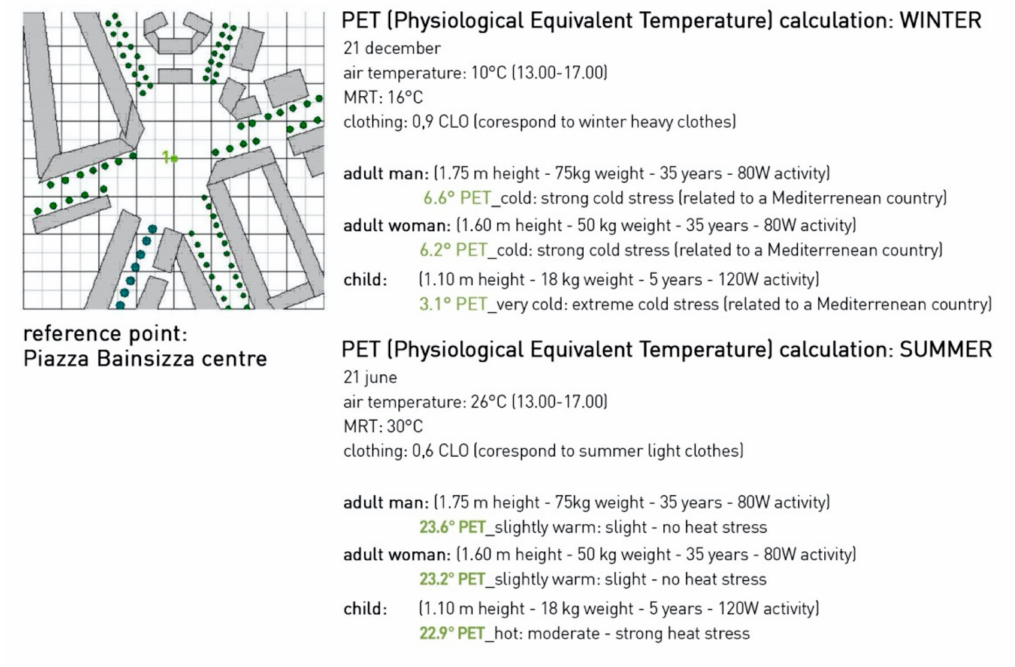
Figure 13. Microclimatic comfort analysis of scenario 1 (S1): PET during winter and